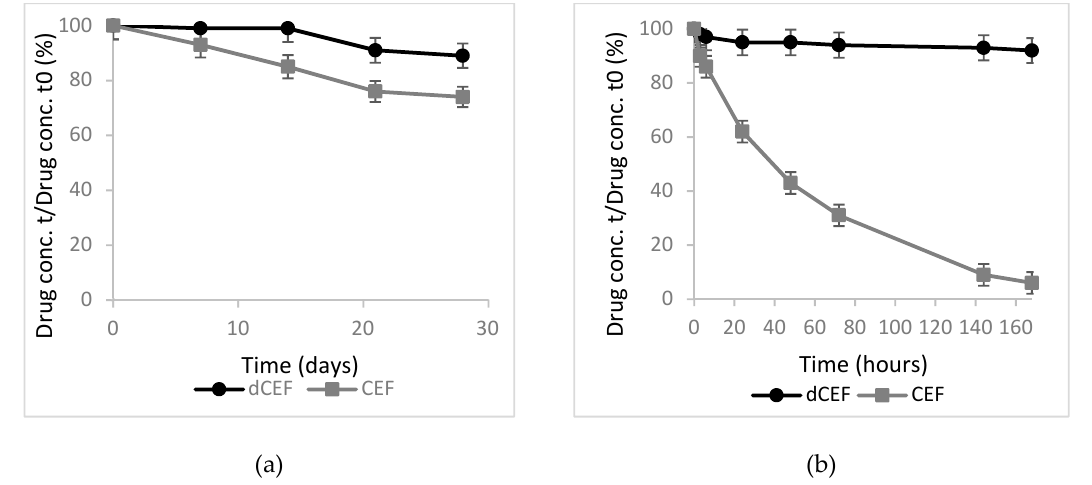
Figure 3. Stability of CEF (grey) and dCEF (black) in 15% v / v Tween ® 80 (each bar represents the mean ± SD; n = 5); ( a ) at 4 ◦ C, for one month: from the 2nd to the 4th weeks dCEF resulted significantly more stable then CEF stored in the same conditions ( p < 0.05); ( b ) at 35 ◦ C, for one week: from 24 h dCEF resulted significantly more stable then CEF ( p < 0.01 to < 0.001).